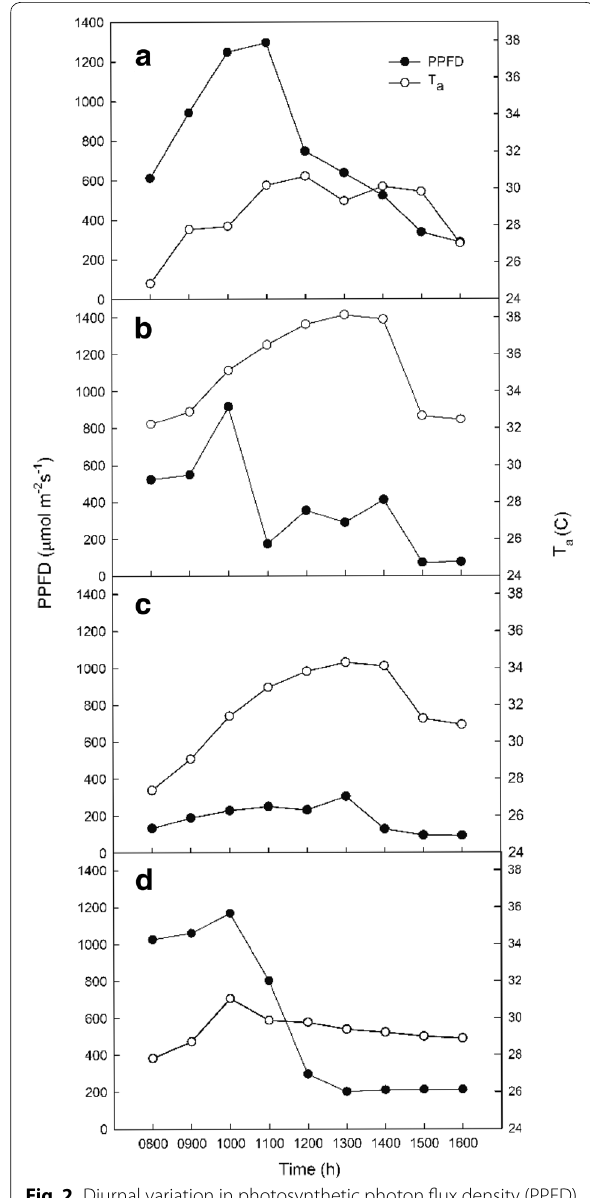
Fig. 2 Diurnal variation in photosynthetic photon flux density (PPFD) and air temperature ( T a ) in 2010: late dry season (27 March; a ), early wet season (26 June; b ), late wet season (25 September; c ), and early dry season (30 December; d